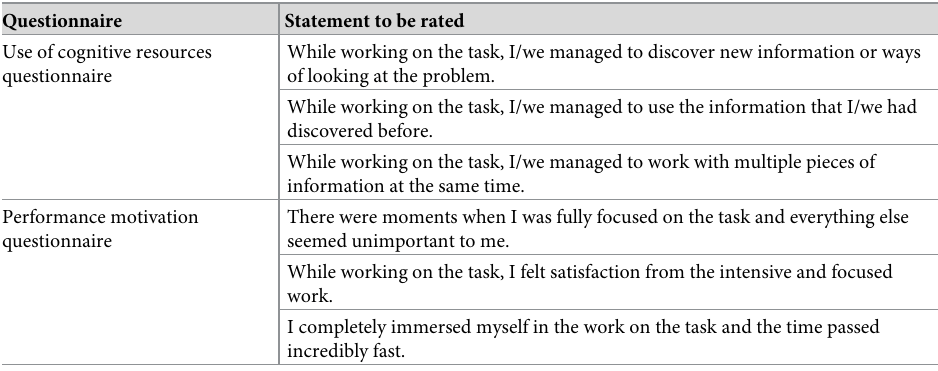
Table 1. Examples of statements used in the questionnaires.